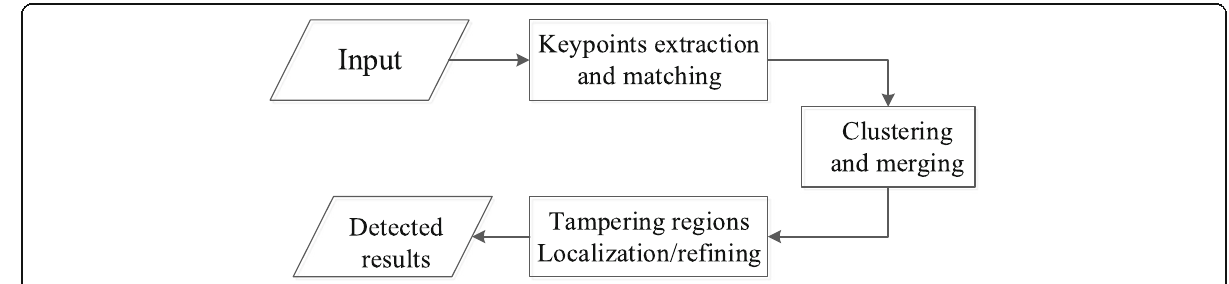
Fig. 2 The flowchart of the proposed